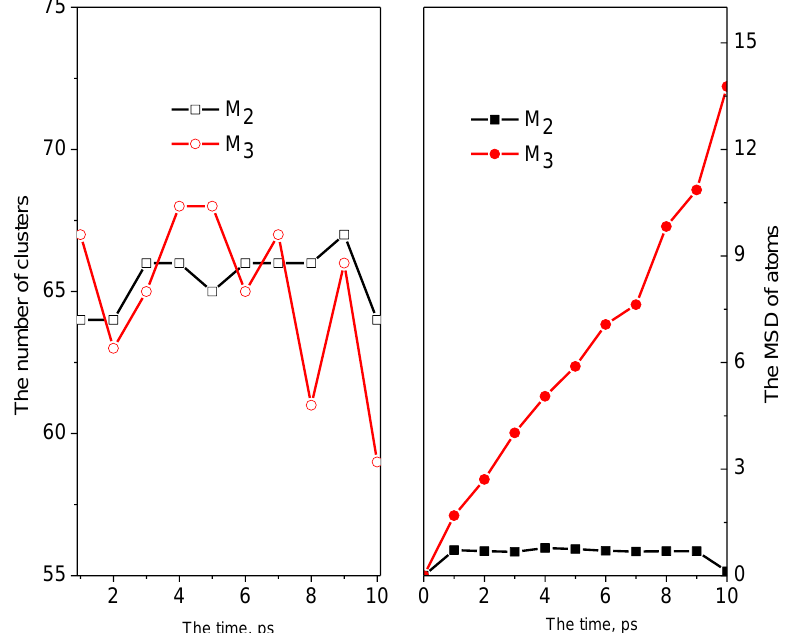
Figure 4. The MSD (left) and number of clusters (right) for atoms of M 2 and M 3 . The set M 2 and M 3 is determined for the configuration at t D = 10 ps and at ambient